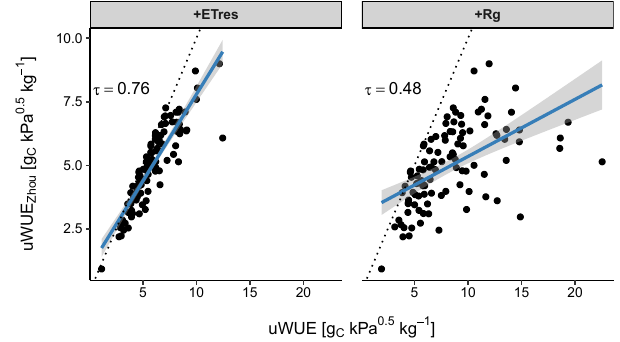
Figure 9. Effect of different model variants on global uWUE esti- mates. The 1 : 1 line is dotted. A linear dependency would indicate that uWUE estimates are commensurable across sites, even if only after a linear scaling. When comparing with the estimates of the original Zhou model, the correlation is notably weaker for + Rg than for + ET res . Sites with high parameter uncertainties were removed for all